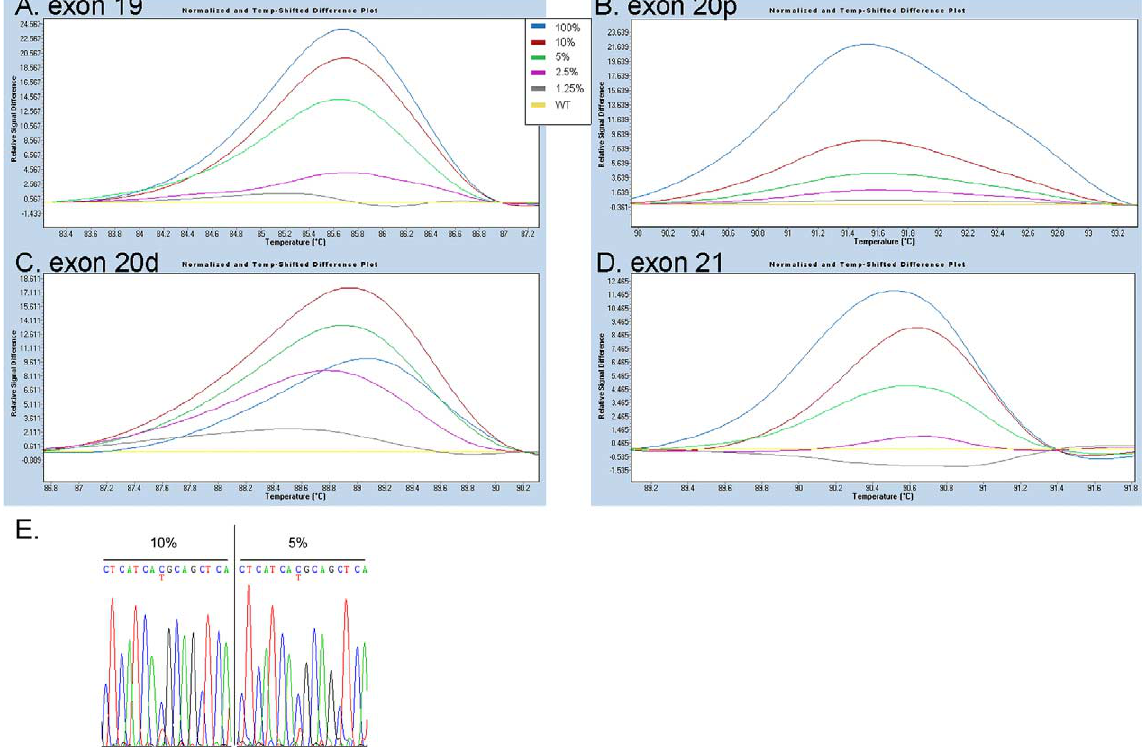
Fig. 1. Panel of HRM assays for EGFR exons 19, 20 and 21. The designed panel of EGFR HRM assays encompasses a pre-screening approach with direct sequencing confirmation possibility. The altered melting of HRM amplicons is best visualized in the normalised and temperature shifted melting plot, in which the relative signal difference of the specimen as compared to a reference WT DNA indicates the likelihood of a mutation. Shown are representative EGFR HRM assay findings for (A) exon 19 on a dilution series of H1650, containing a deletion in EGFR exon 19, (B) exon 20/region 20p (proximal region) on a dilution series of EK1472, containing an insertion in EGFR exon 20, (C) exon 20/region 20d (distal region) on a dilution series of H1975, containing T790M, and (D) exon 21 on a dilution series of H1975, containing L858R. (E) The pre-screen assay may be followed by direct sequencing of HRM PCR products that showed an aberrant melt out to find out the nature of the EGFR mutation. Representative examples of the sequencing results of the HRM products for exon 20/region 20d of 10% and 5% H1975 DNA, respectively, in WT-DNA background is shown, indicating both the T790M